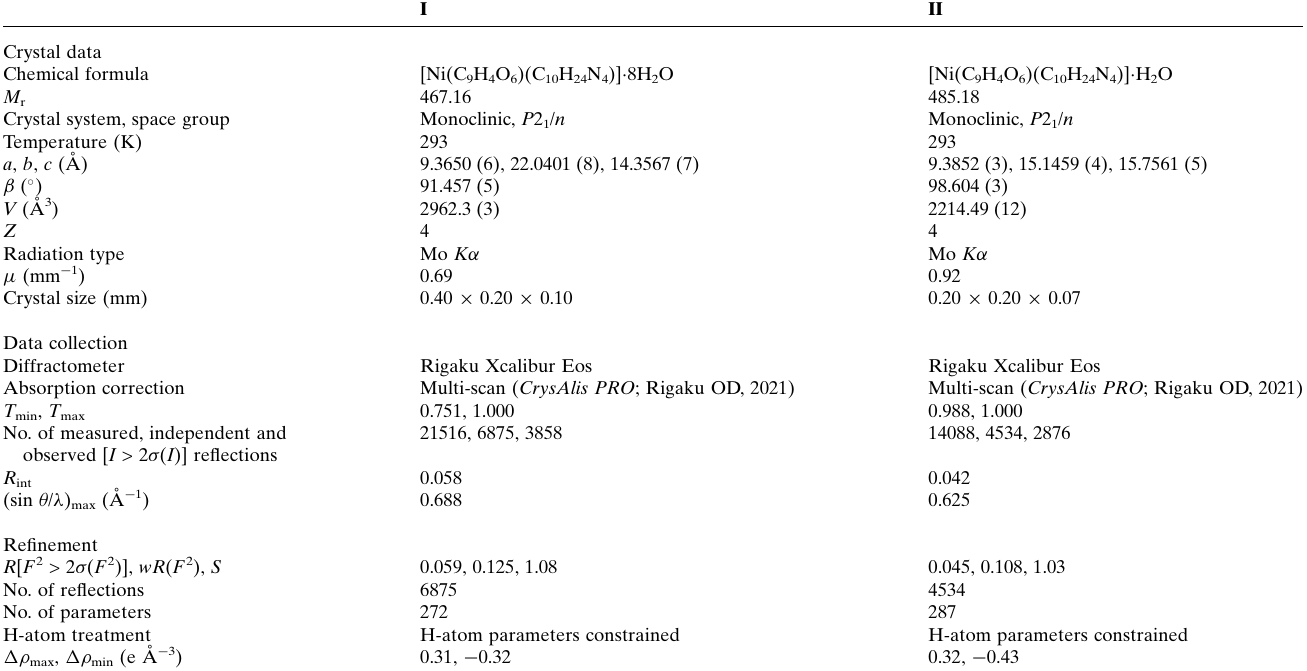
Table 4 Experimental details.